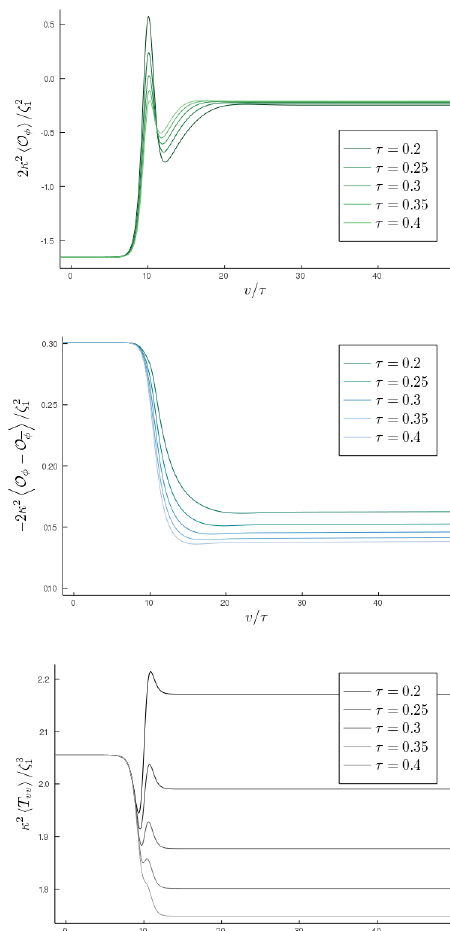
= 10 and χ = 2.0, and set i f